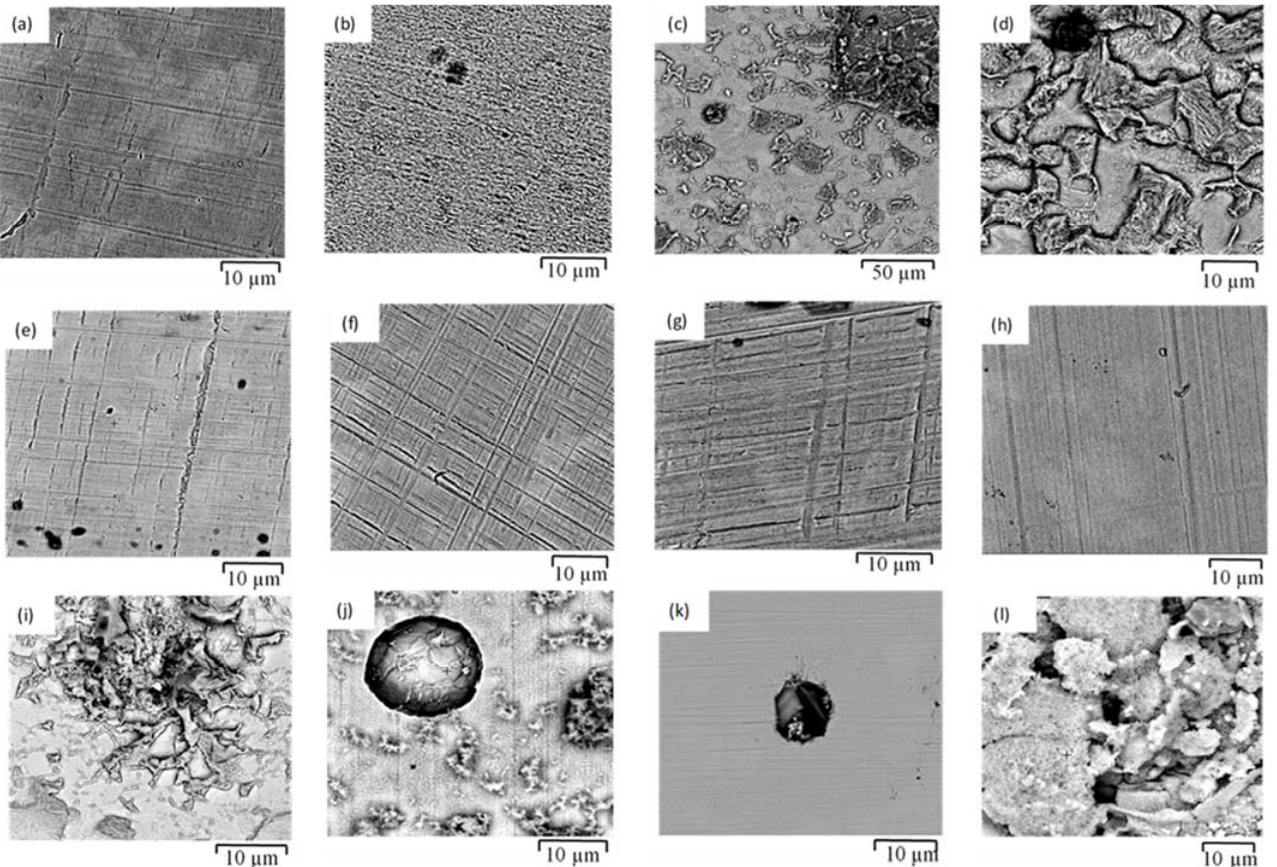
Figure 14. SEM micrographs of morphology of mild steel exposed to different simulated solutions of: ( a , b ) SW for 3 h, ( c ) SW for 72 h, ( d ) SW for 168 h, ( e ) NC for 168 h, ( f ) HPC for 168 h, ( g ) SWSSNC for 168 h, ( h , i ) SWSSHPC for 3 h, ( j ) SWSSHPC for 72 h and ( k , l ) SWSSHPC for 168 h.